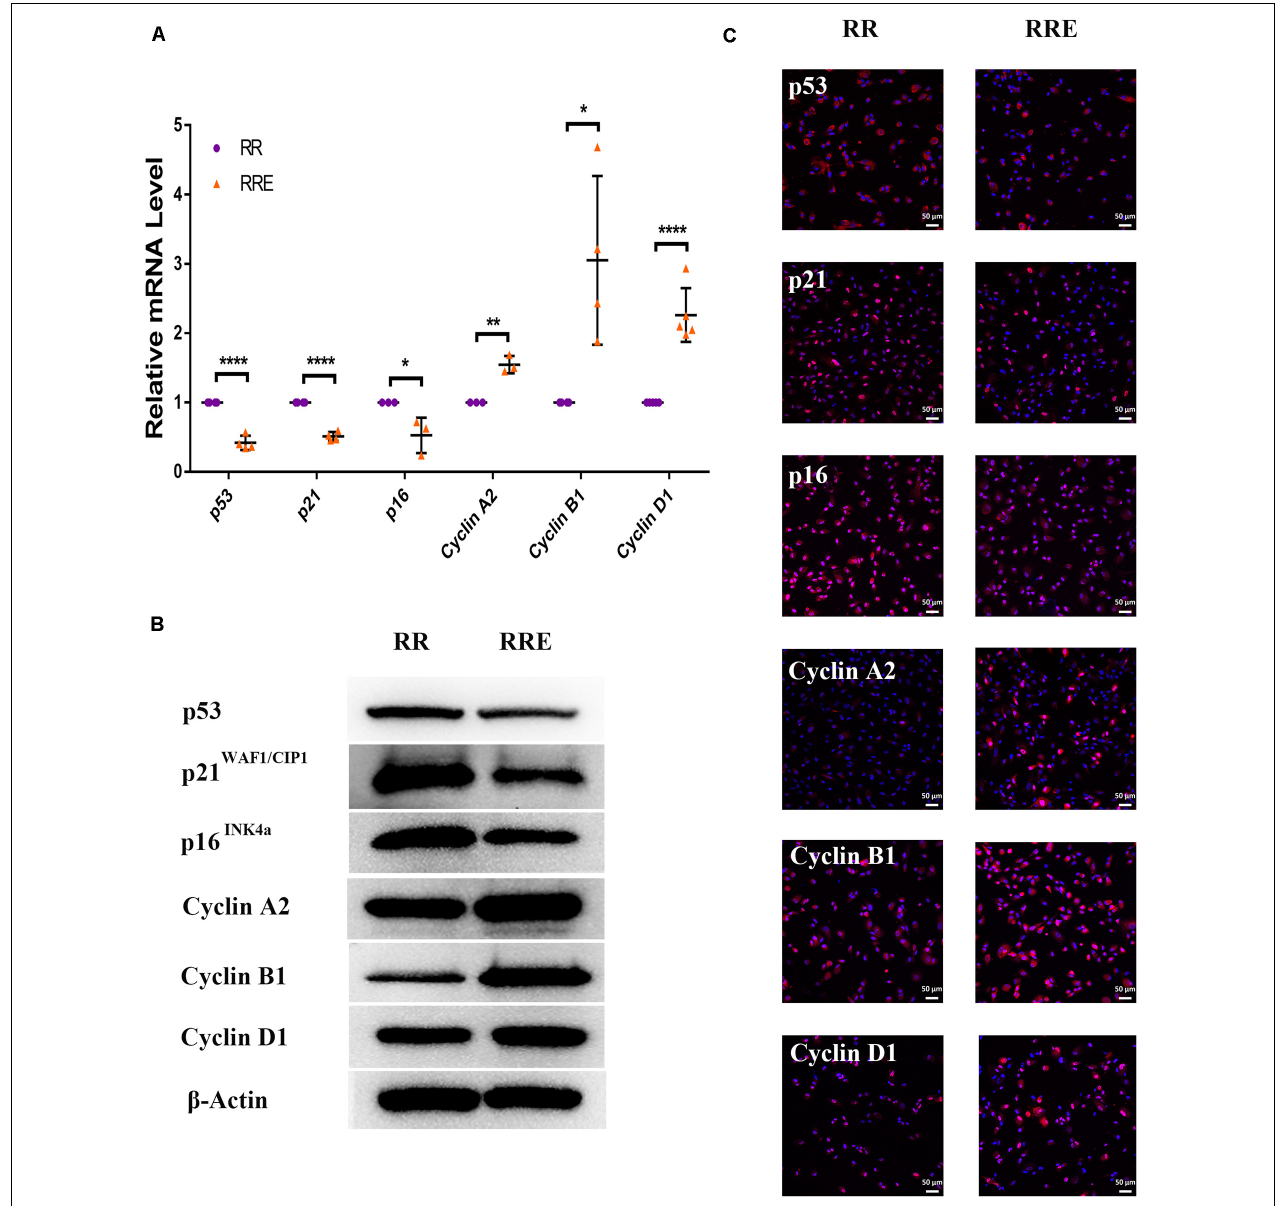
FIGURE 7 | The cocultured ESCs downregulated senescence-related positive markers and upregulated senescence-related negative markers in replicative senescent RPE cells. (A) Expression of cellular senescence-related markers in the RR and RRE groups, as assessed by RT-qPCR ( n ≥ 3 biological repeats). (B) Results for cellular senescence-related markers in the RR and RRE groups as determined by western blotting. β -Actin was used as the internal reference. (C) The expression levels of cellular senescence-related markers in the RR and RRE groups as determined by immunofluorescent staining. Scale bar, 50 µ m. Data are presented as the mean ± SD. ∗ P < 0.05; ∗∗ P < 0.01; ∗∗∗∗ P < 0.0001.